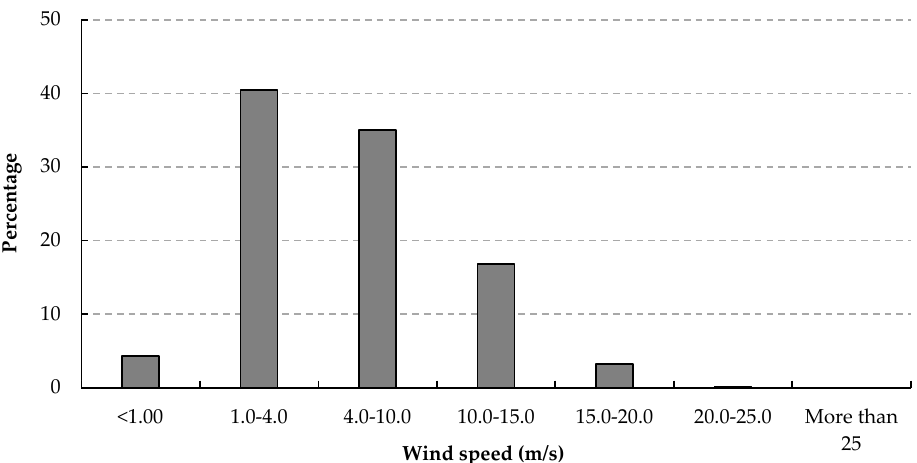
Figure 5. Windrose diagram of Zabol station.